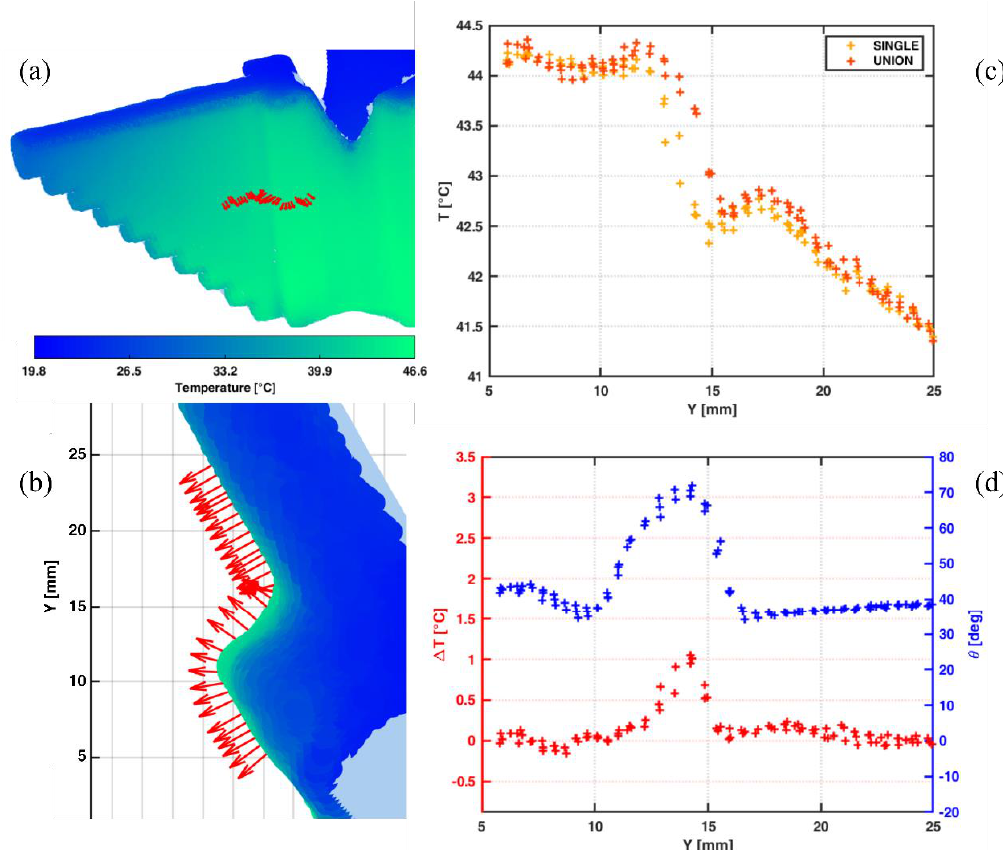
Figure 14. Effect of the temperature correction achieved by the union of different thermograms. ( a ) Zone in which the temperatures are examined, with the vectors normal to the surface in these points colored red; temperatures are shown with a “winter” colormap ; ( b ) Close-up of the normal vectors, from a top view; ( c ) Comparison between the temperature of a single thermogram and the one resulting from the union of several thermograms; ( d ) Temperature difference ( T resulting from the union minus T of the single thermogram) and viewing angle for each point examined.